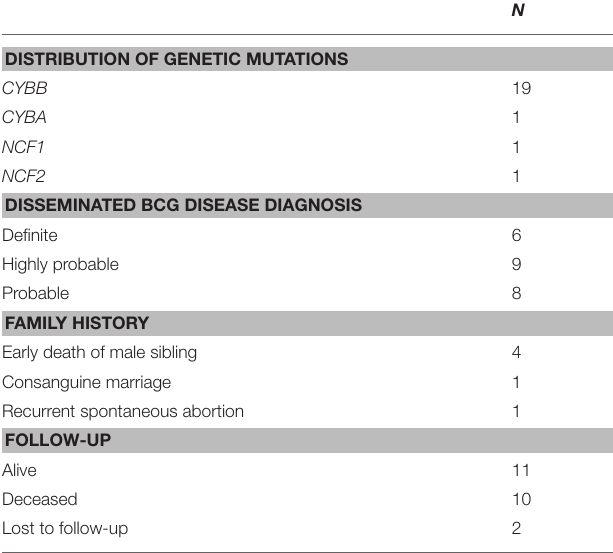
TABLE 2 | Patient